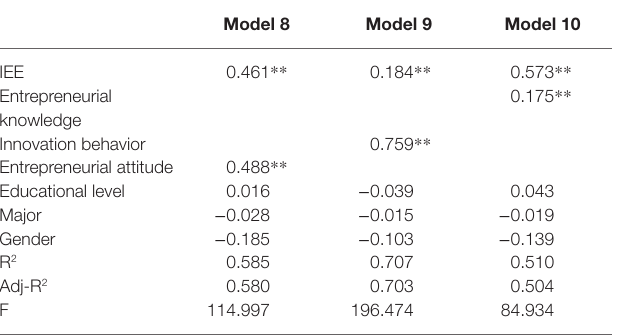
TABLE 9 | Regression analysis results (dependent variable: Entrepreneurial intention).